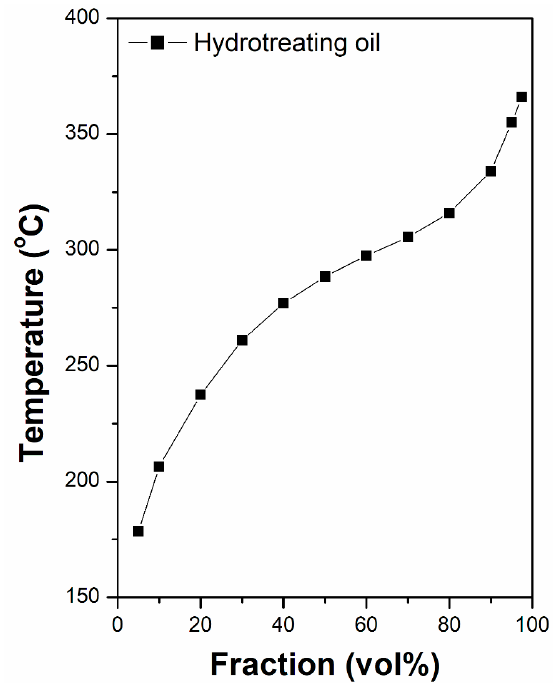
Figure 6. Distillation curve of hydrotreating oil, which is produced by deep hydrotreating of middle distillates over sulfide NiMo/ γ -Al 2 O 3 catalyst at 350 °C and 7 MPa of H 2 for 5 h.